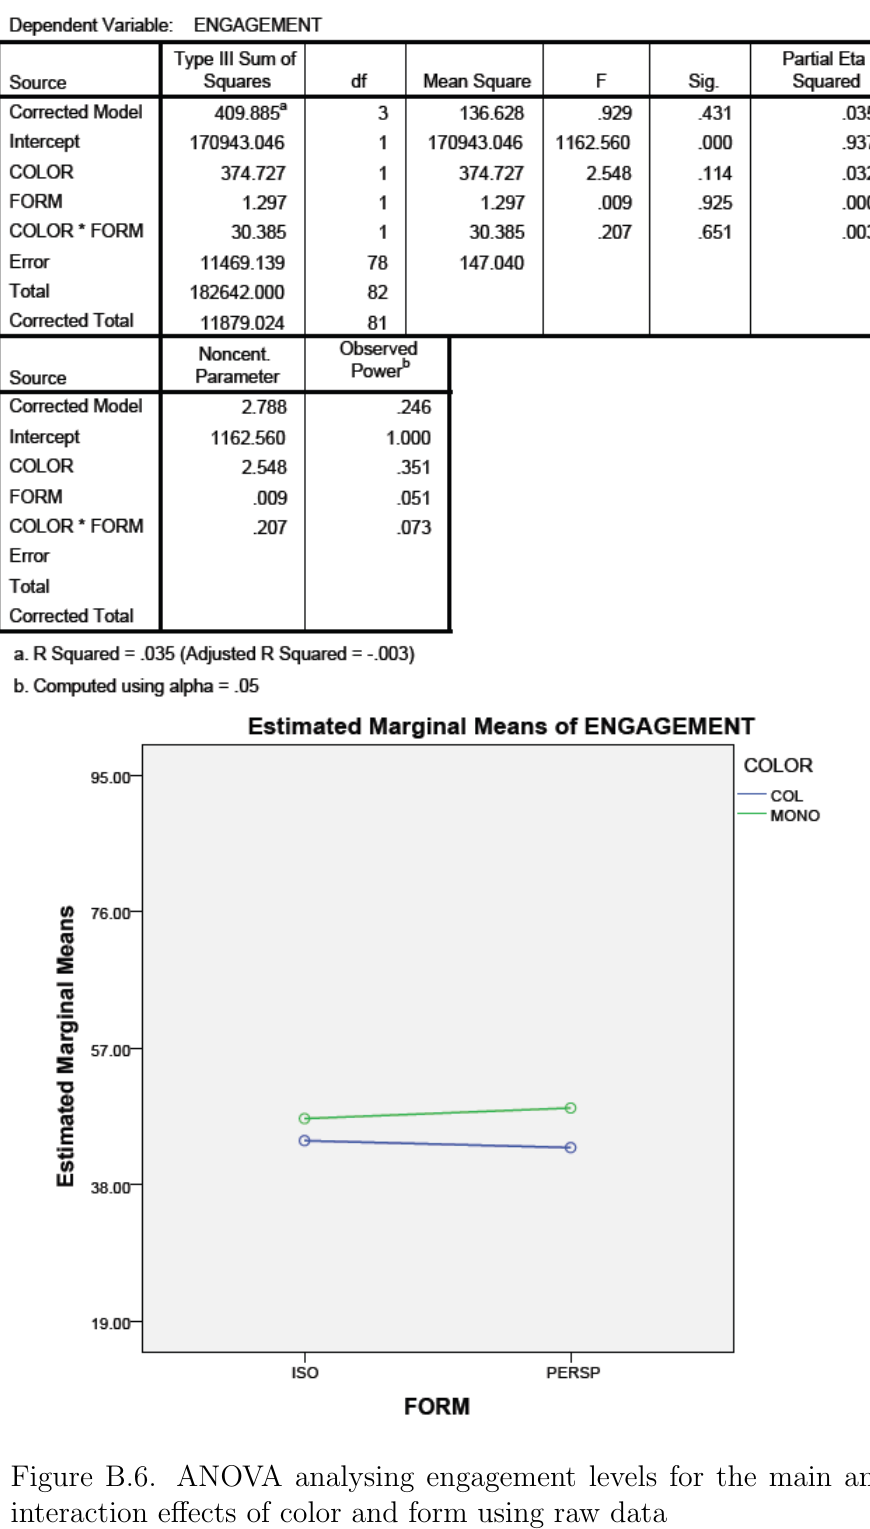
Figure B.6. ANOVA analysing engagement levels for the main and interaction effects of color and form using raw